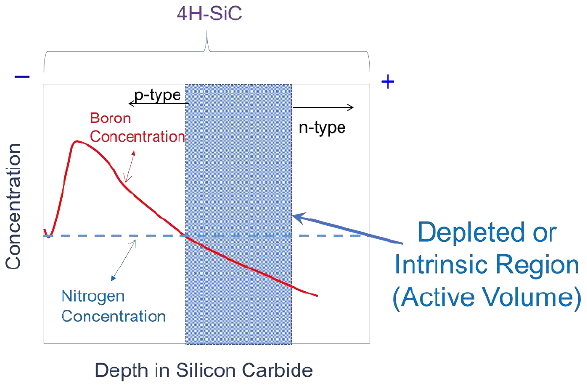
Fig. 2. Application of a reverse bias produces a depletion region, which acts as the active volume for the detector. A partially depleted detector is shown. The maximum depletion depth corresponds to the full thickness of the initial n - region (distance from the p-n interface to the remainder of the epitaxial layer).